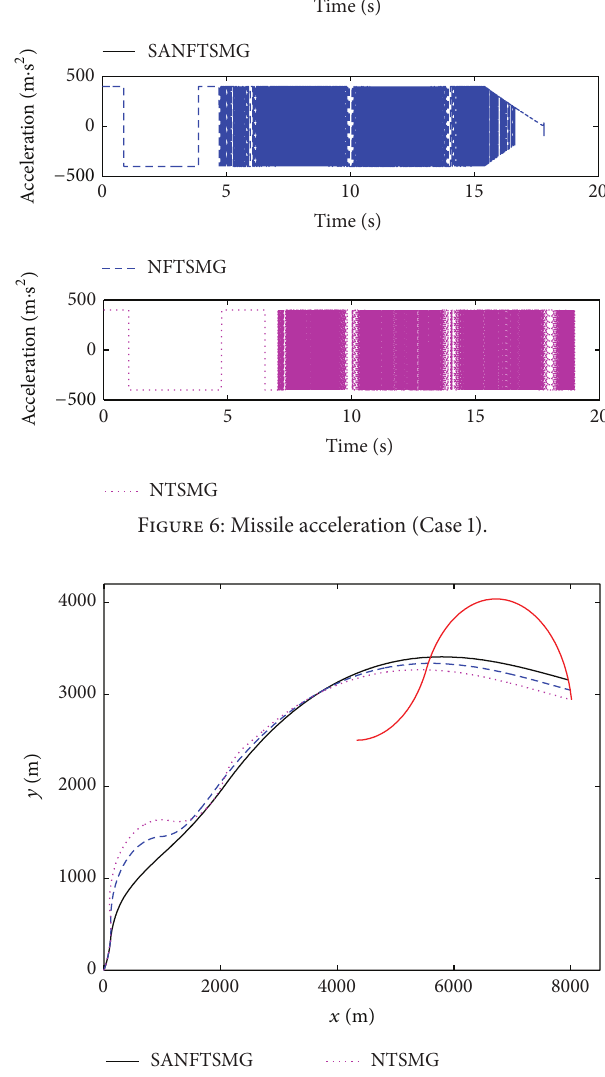
Figure 7: Trajectories of missile and target (Case 2).